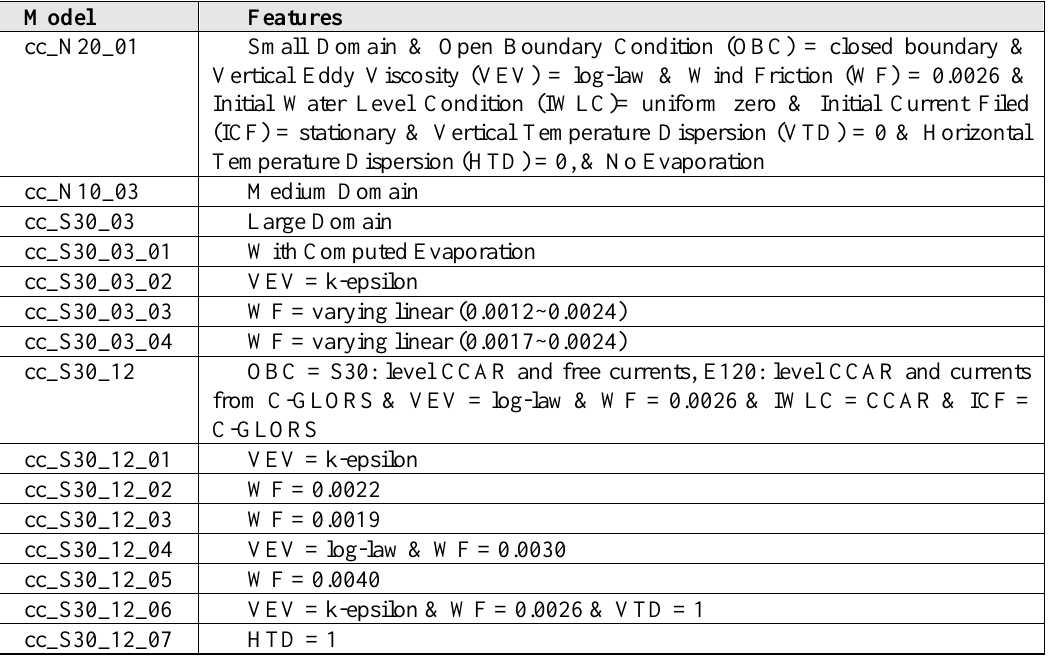
Table1. Model Calibration Versions